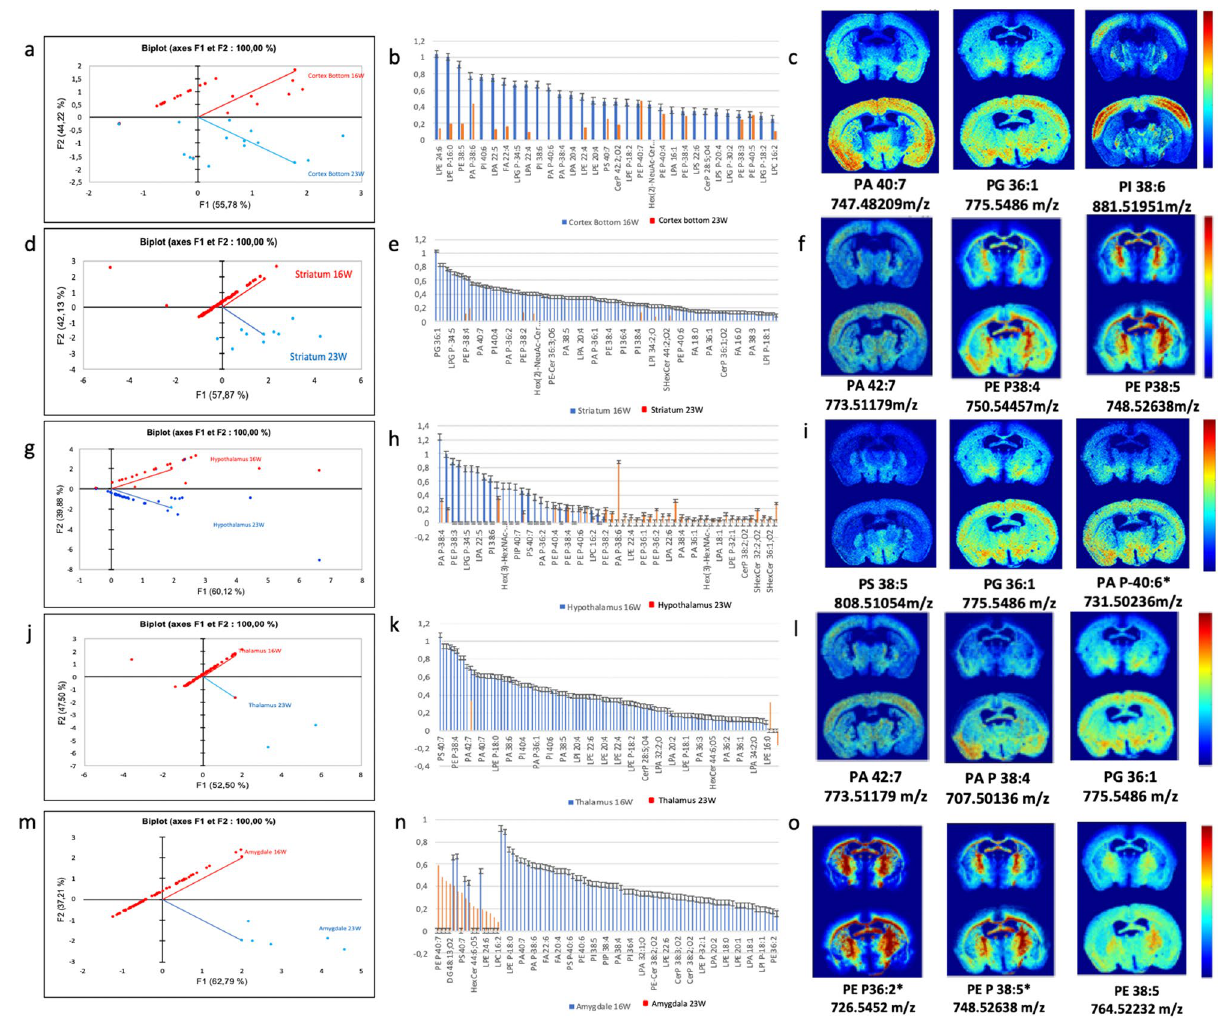
Figure 7. (a) PCA score plot of log ratios of lipids signal of cortex region in obese and control brain sections at week 16 and week 23, (b) histogram of log ratio obese vs control in the cortex, (c) MALDI images generated of m/z found significantly differentiated in obese brain in regard to control (p < 0.05) in the cortex region. (d) PCA score plot of log ratios of lipids signal of striatum region in obese and control brain sections at week 16 and week 22, (e) histogram of log ratio obese vs control in the striatum, (f) Images generated of m/z found significantly differentiated in obese brain in regard to control (p < 0.05) in the striatum region. (g) PCA score plot of log ratios of lipids signal of hypothalamus region in obese and control brain sections at week 16 and week 23, (h) histogram of log ratio obese vs control in the hypothalamus, (i) images generated of m/z found significantly differentiated in obese brain in regard to control (p < 0.05) in the hypothalamus region. (j) PCA score plot of log ratios of lipids signal of thalamus region in obese and control brain sections at week 16 and week 23. (k) Histogram of log ratio obese vs control in the thalamus, (l) images generated of m/z found significantly differentiated in obese brain(the bottom image) in regard to control (the top image) (p < 0.05) in the thalamus region. (m) PCA score plot of log ratios of lipids signal of amygdala region in obese and control brain sections at week 16 and week 23, (n) histogram of log ratio obese vs control in the amygdala, (o) images generated of m/z found significantly differentiated in obese brain in regard to control (p < 0.05) in the amygdala region (PCA were obtained using XLSTAT software (Addinsoft 2020. XLSTAT statistical and data analysis solution. New York, USA and mass spectrometry images with MSi reader Comparison of lipid profile over time in the thalamus. The PCA for the thalamus showed that all the lipids except 3 were aligned and correlated at T16 (Fig. 7j). Log-ratio analysis showed that the lipid with the highest ratio at T16 in this brain region was the phosphatidyl serine PS 40:7 (Fig. 7k). The thalamus had high presence of several poly lipids with a fairly long medium chain